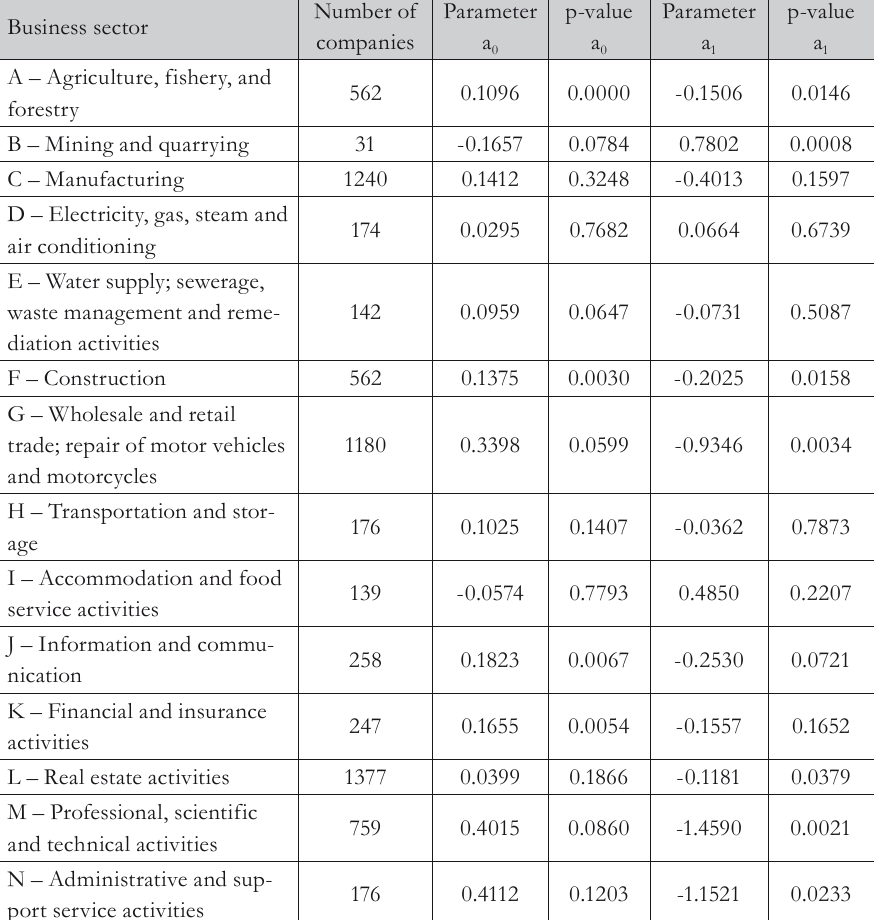
Tab. 5 – Estimation of parameters by linear regression according to the business sector.